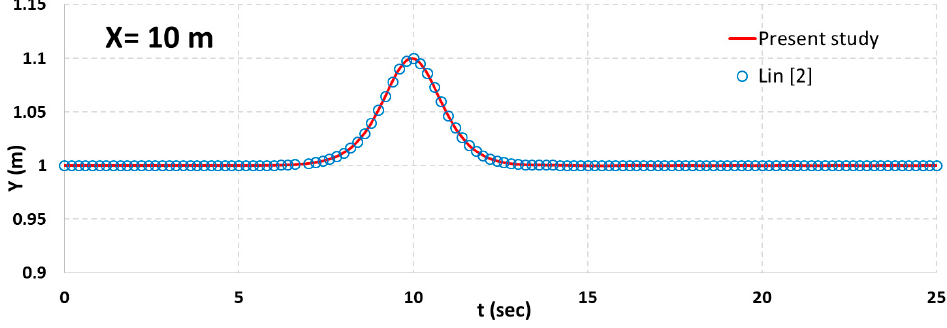
Figure 4. A comparison of the time history of the free-surface elevation at x = 10.0 m between the present study (solid line) and the Lin [2] study (circle).